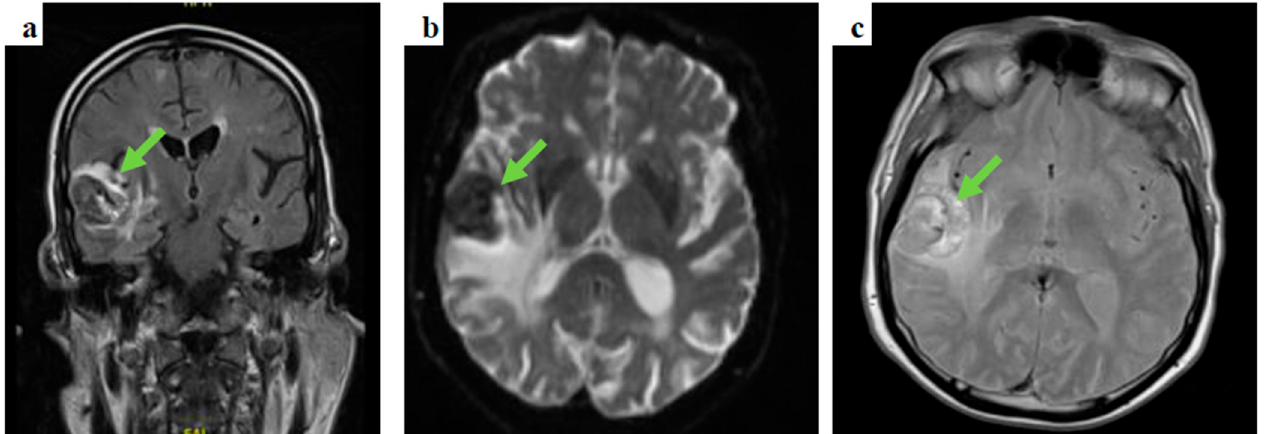
Figure 2. Gadolinium-enhanced brain MRI images: ( a ) coronal, fluid-attenuated inversion recovery (FLAIR) sequence showing a right temporal lobe lesion, ( b ) an axial, diffusion-weighted image (DWI), b1000 showing the temporal lesion surrounded by vasogenic oedema, and ( c ) an axial, T2-weighted imaging showing a high intensity lesion in keeping with the presence of either subacute stage blood products or melanin.